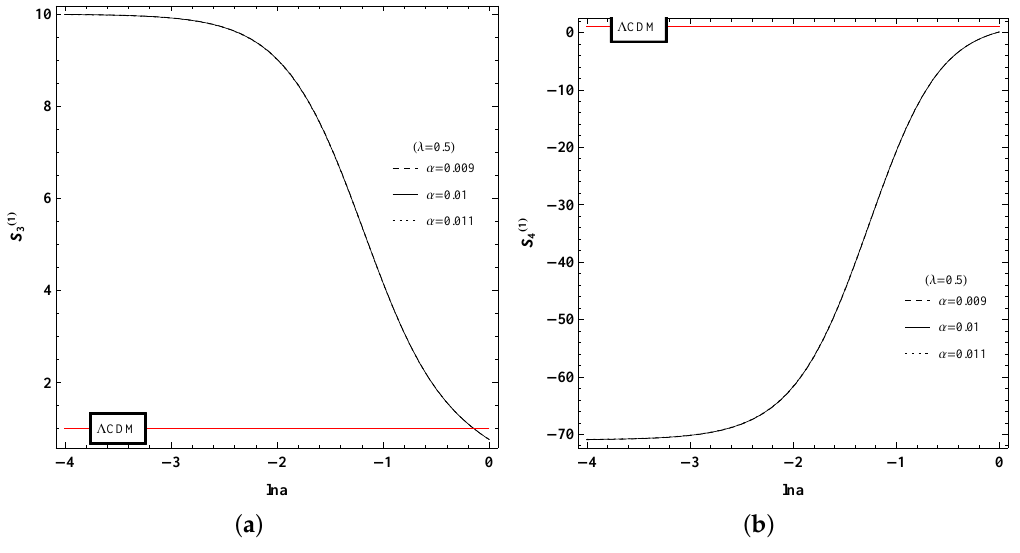
( 1 ) for P 1 with different parameters α and fixed λ = 0.5. ( b ) Graph of S 3